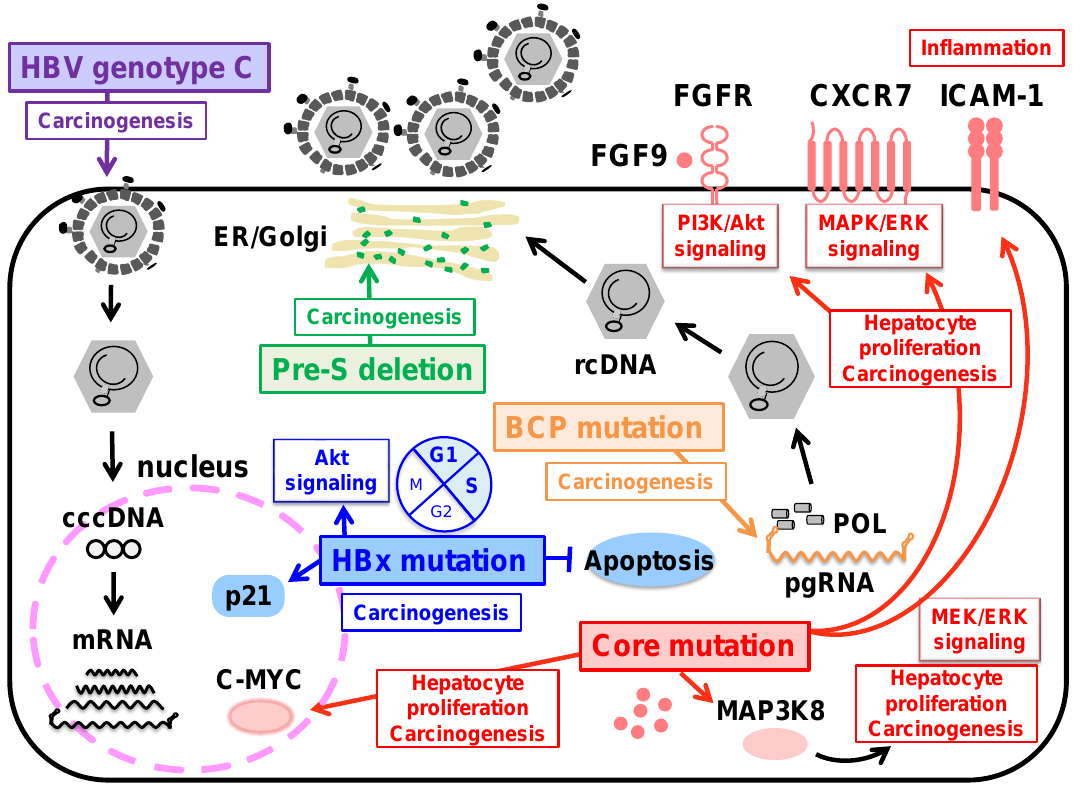
Figure 2. Schematic representation for hepatocellular carcinogenesis associated with HBV pre-S/BCP/Core/X mutations and HBV genotype C. The deletion in the PreS1 and preS2 region may cause overproduction and accumulation of mutated L protein in the endoplasmic reticulum, resulting in inducing HCC development. BCP mutations at nucleotides A1762T and G1764A associated with HBV e antigen (HBeAg) seroconversion and enhancing viral replication is important for carcinogenesis. HBx mutations may regulate apoptosis and transcription indirectly by acting on host cell pathways. The core A2051C mutation in genotype F1b enhancing viral replication mediates in up-regulation/activation of host cell pathways, leading to hepatocellular carcinogenesis. HBV genotype C with high replication efficiency induces oxidative stress and fibrosis, which contributes to hepatocellular